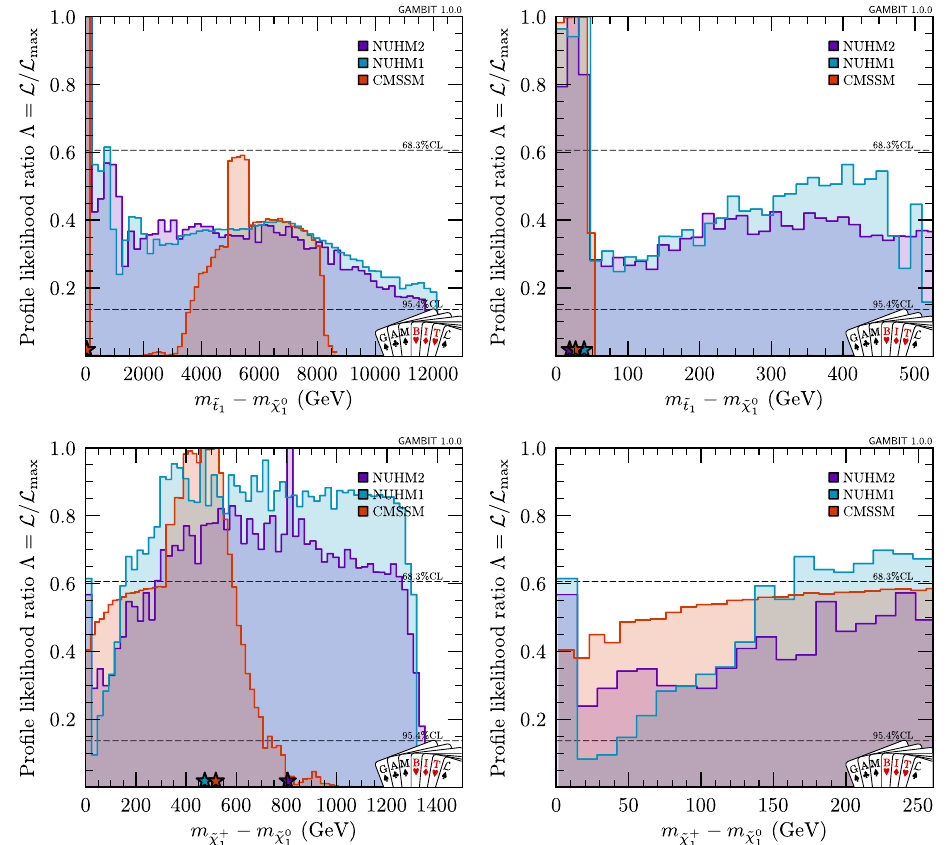
− m − m (top) and m ˜ χ + (bottom), in the CMSSM (red), NUHM1 (blue) and ˜ χ 0 ˜ χ 0 1 1 1 1